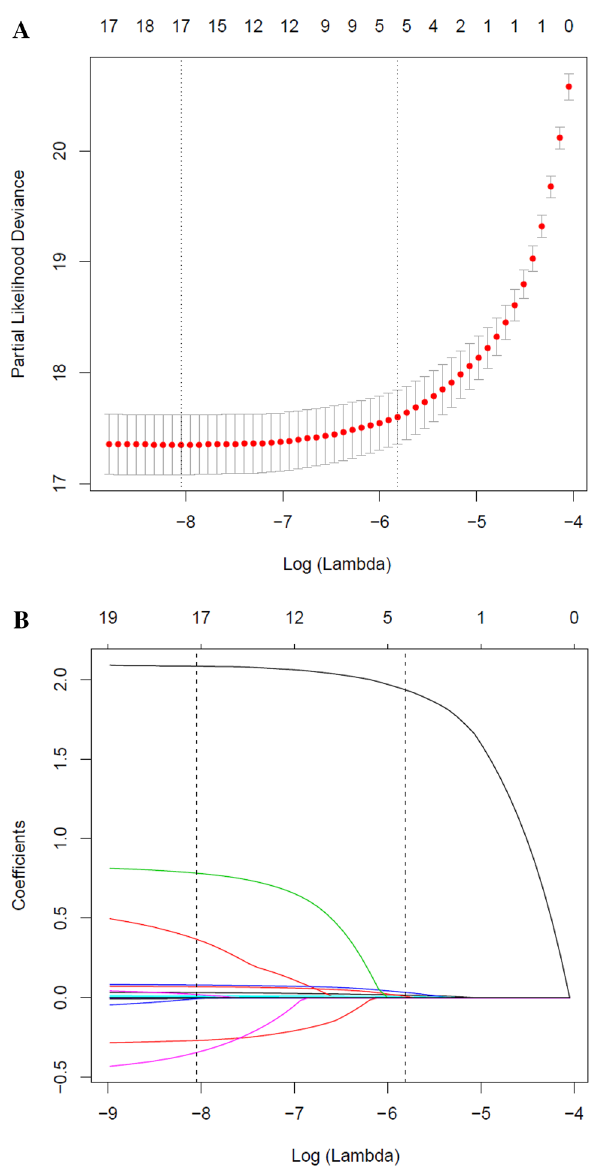
Figure 2. Risk predictors selection using the LASSO logistic regression model. ( A ) Optimal predictor (lambda) selection in the LASSO model with fivefold cross validation by minimum criteria. The area under the receiver operation characteristic curve was plotted versus log (lambda). Dotted vertical lines were drawn at the optimal values by using the minimum criteria and the 1 SE of the minimum criteria; ( B ) LASSO coefficient profiles of the 15 predictors. A coefficient profile plot was developed against the log (lambda) sequence. Vertical line was drawn at the value selected with fivefold cross validation, where optimal lambda resulted in 5 predictors with nonzero coefficients (lambda = 0.003).